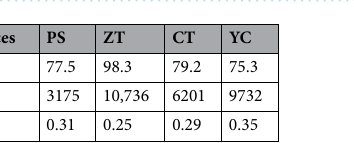
Table 3. Evaluation indices of the uncertainty interval during the validation